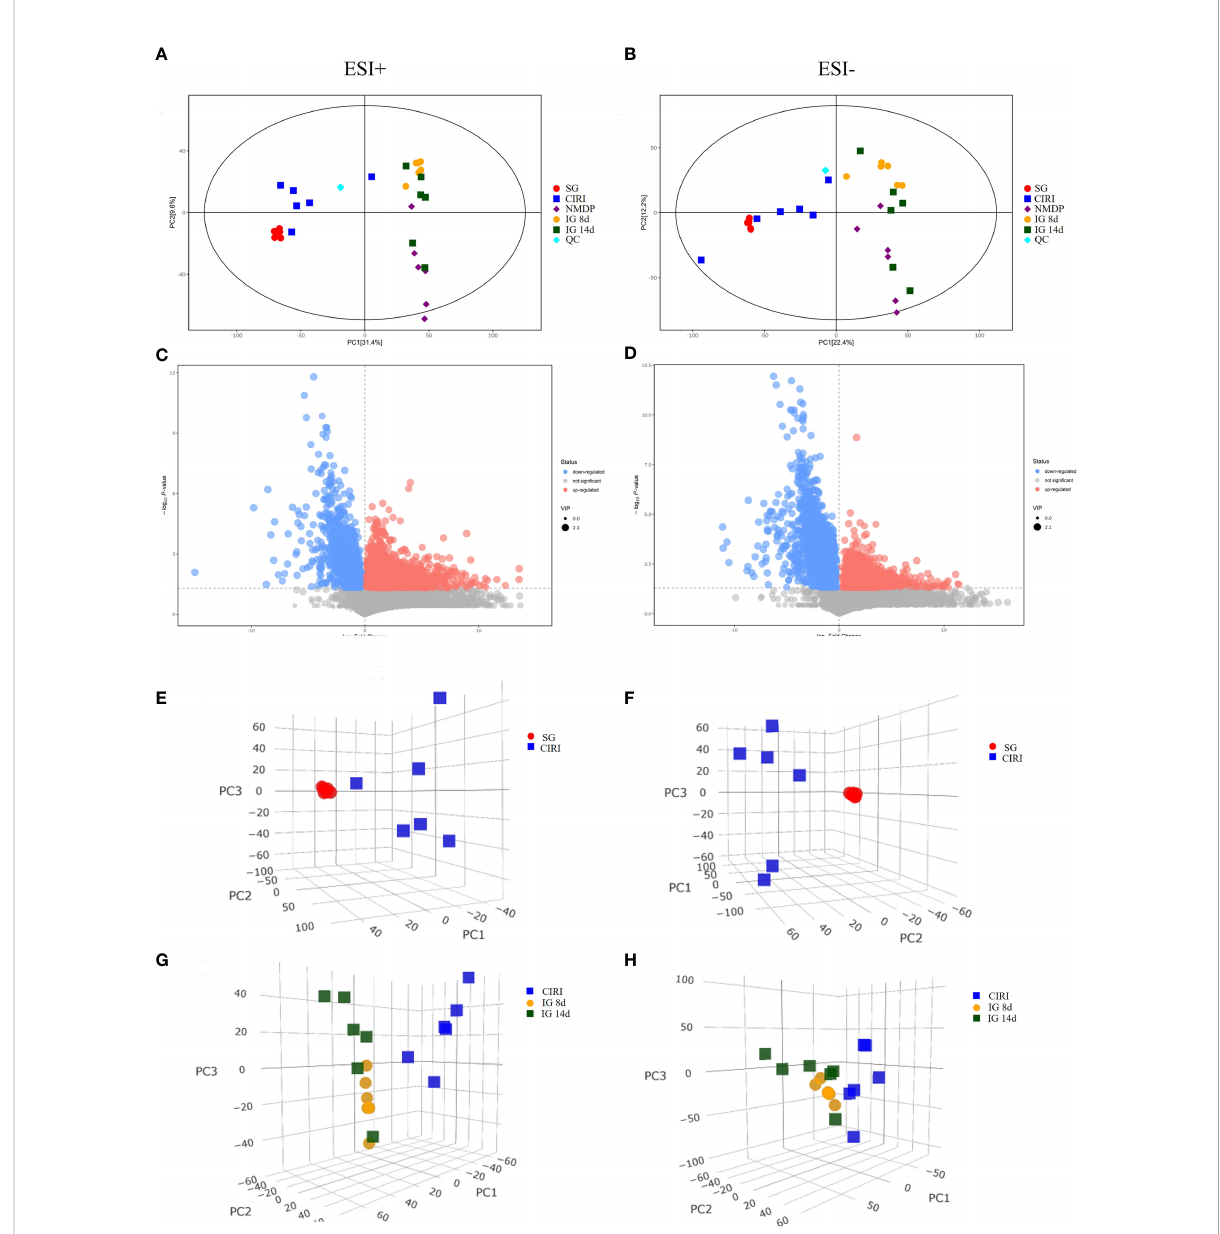
FIGURE 8 PCA score plot (2D and 3D) and volcano plot of the SG and CIRI group in positive and negative mode. Note: PCA score plot (2D) in positive (A) and negative (B) mode. Volcano plot of the SG and CIRI group in positive (C) and negative (D) mode. PCA score plot (3D) of the SG and CIRI group in positive mode (E) and in negative mode (F) . PCA score plot (3D) of CIRI, IG 8d, and IG 14d groups in positive mode (G) and in negative mode (H)